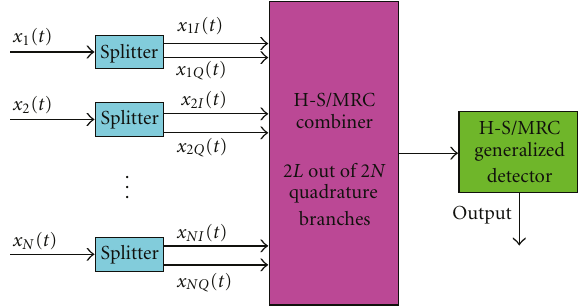
Figure 1: Block diagram receiver based on GR with quadrature subbranch HS/MRC and HS/MRC